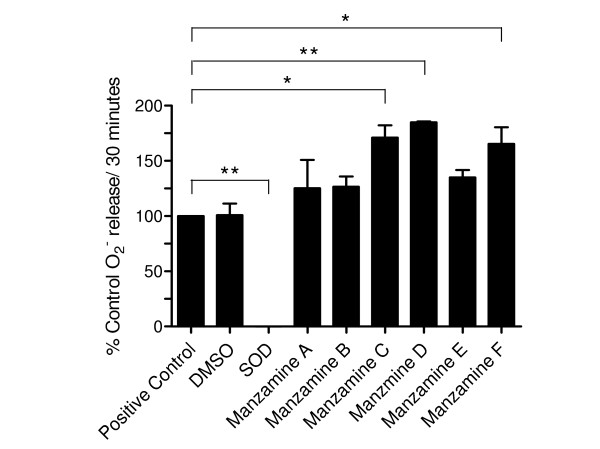
Differential effect of manzamine A, B, C, D, E and F and superoxide dismutase on hypoxanthine-xanthine oxidase system-generated O2-. Cell-free source of O2- was generated by a standard hypoxanthine-oxidase system as described in Materials and Methods. Data are expressed as O2- released (nmoles O2-/30 min) and correspond to the mean ± SD of 2 representative experiments in duplicate. * P < 0.05, ** P < 0.01 versus control.